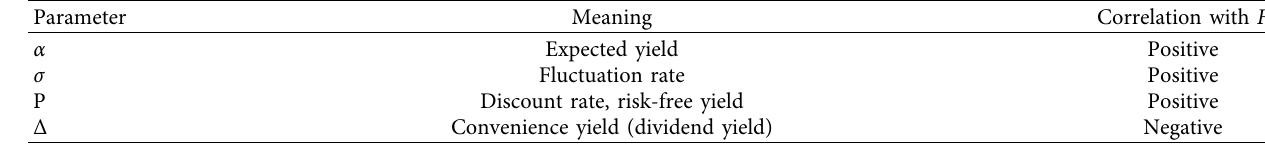
Table 2: Relationship between classic real option parameters and project value.